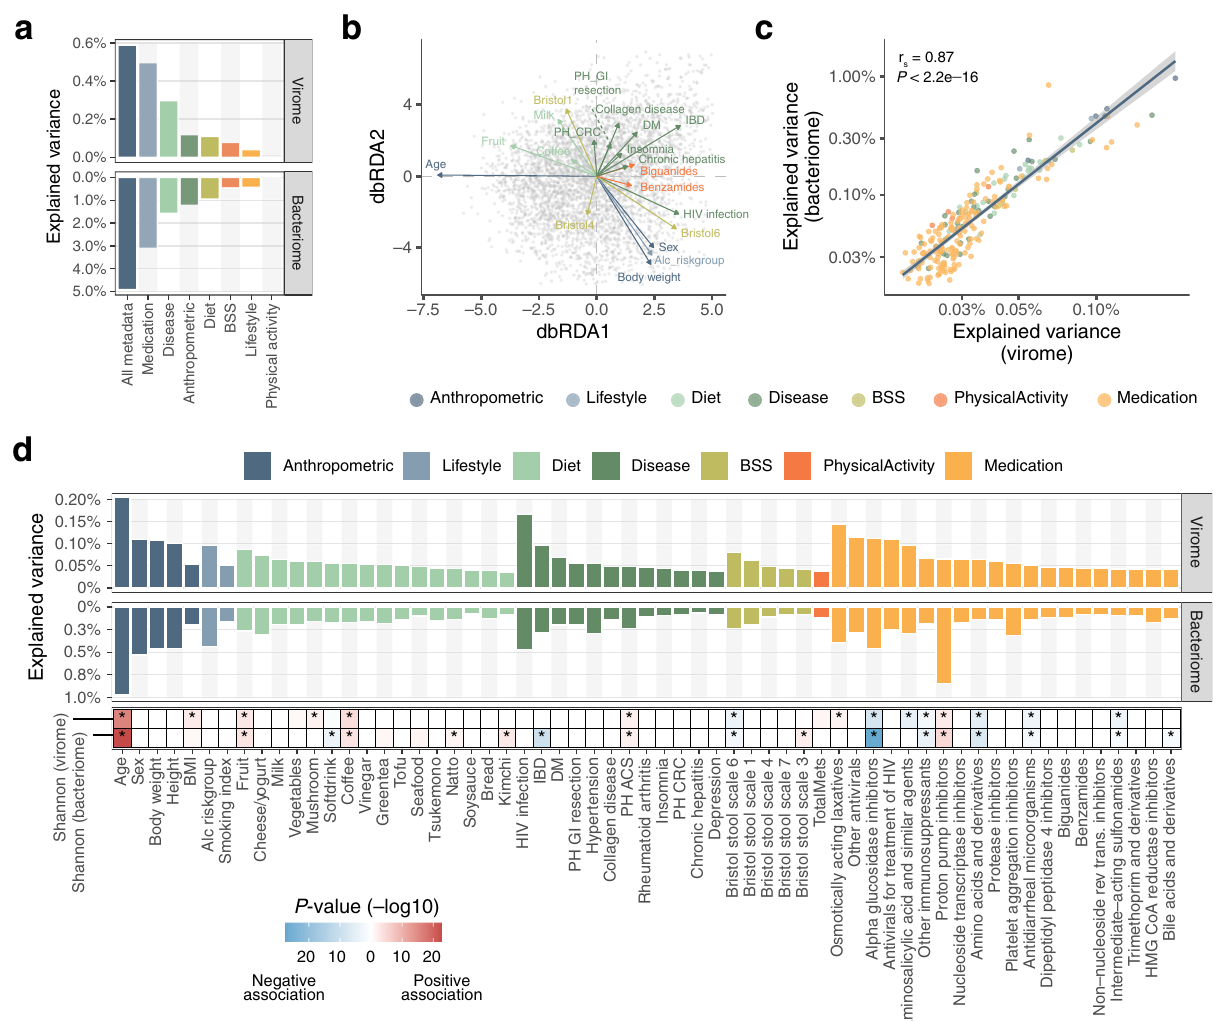
Fig. 5 | Host and environmental factors signi fi cantly associated with the gut virome. a Proportion of the variance explained by each metadata category in the gutviromeandbacteriome( n =4,198individuals)assessedbyredundancyanalysis. b Distance-based redundancy analysis showing the association between the 4,198 virome pro fi les at the vOTU level and collected metadata. Gray plots show each viralpro fi le,andarrowsrepresentassociationswiththemetadata.Thelengthofthe arrow indicates the strength of the association, and the colour represents the metadata category. The top 20 non-redundant metadata with the strongest asso- ciations are shown in the plot. c Positive correlations between the explained var- iance of the gut virome and bacteriome by each metadata. Each point represents metadata and its colour indicates the metadata category. The blue line represents the regressionline,and the greyshadow shows95%con fi denceinterval.Spearman correlationanditsstatisticalsigni fi cantwascalculatedusingthecor.testfunctionin